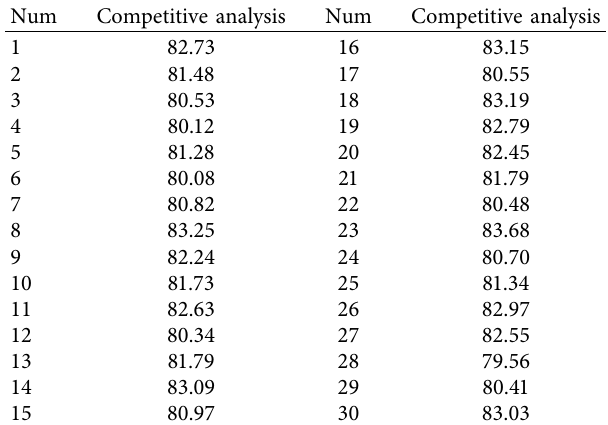
Table 1: Statistical table of the accuracy rate of the analysis model of the competitiveness of international trade of small commodities based on the numerical simulation algorithm. Num Competitive analysis